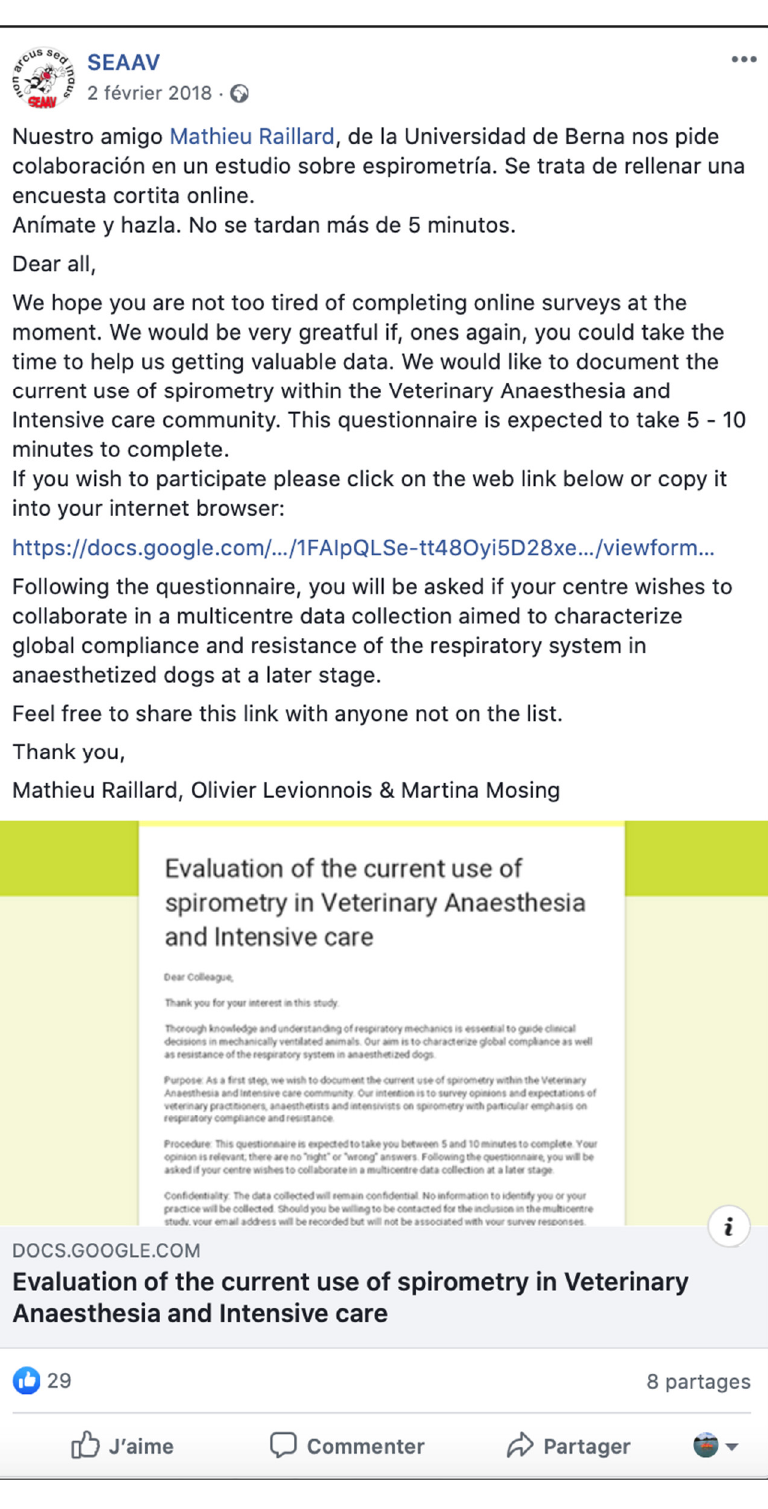
Figure A2. Example of survey announcement on the Facebook page of the Sociedad Española de Anestesia y Analgesia Veterinaria (SEAAV).